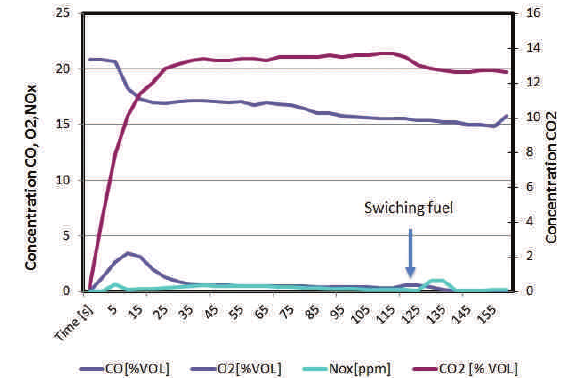
Fig. 7. Cumulative NOx emissions in the fume gases from cold start to fuel switching moment